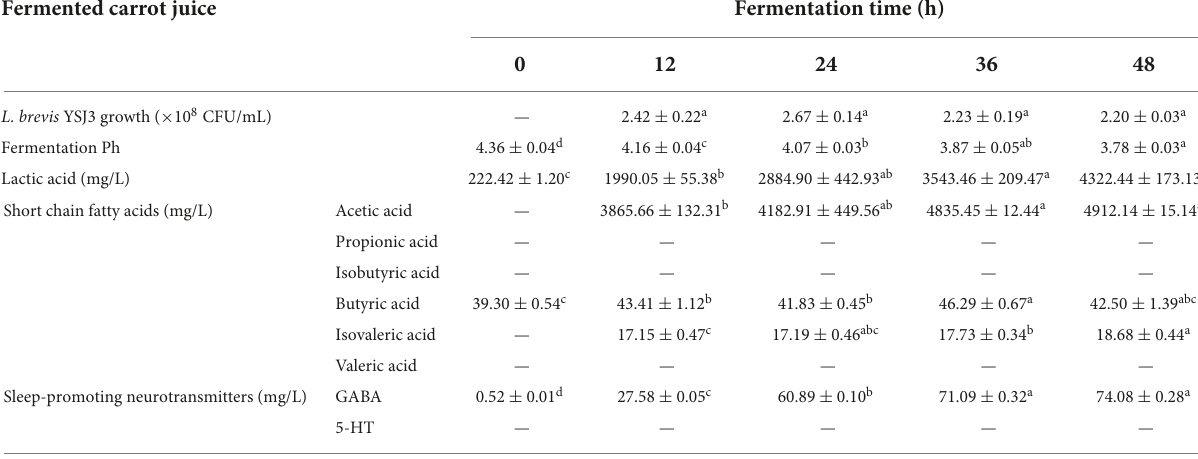
TABLE 1 L. brevis YSJ3 growth, pH, lactic acid, short chain fatty acids, and neurotransmitters in fermented carrot juice at different fermented time. Fermented carrot